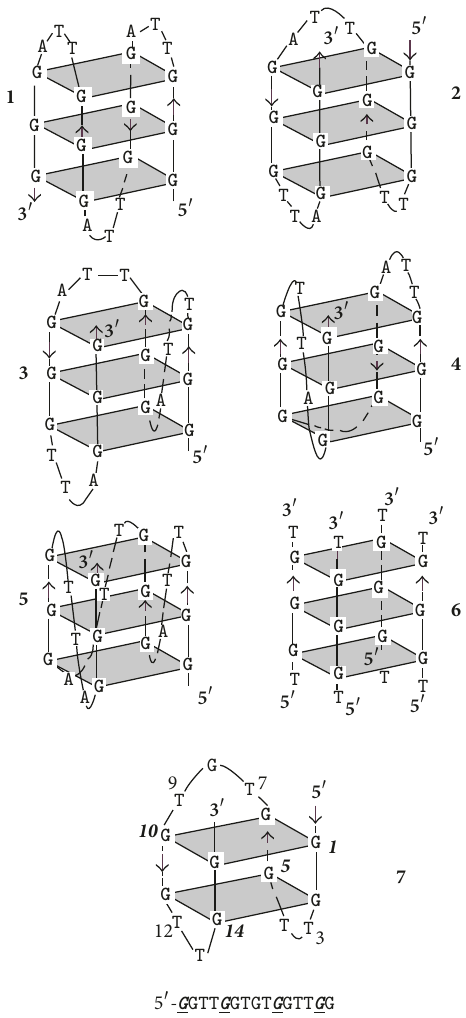
Figure 2: Folding arrangements of the most often cited GQ structures. The intramolecular GQ architectures adopted by the 21-mer htel-21 G 3 (TTAG 3 ) 3 oligodeoxynucleotide under various solution conditions, topologies 1 – 5 . The basket-type antiparallel with 5 󸀠 -to-3 󸀠 edgewise- diagonal-edgewise loops, forming in Na + (topology 1 ); the chair-type antiparallel with three edgewise loops (topology 2 ); the (3 + 1 strands) hybrid-1 with propeller-like, edgewise, and edgewise loops (topology 3 ); the hybrid-2 with two edgewise loops followed by a propeller-type loop (topology 4 ), both hybrids forming in K + solution; the parallel topology with all three loops in propeller-like configuration, as found in crystals containing K + ions (topology 5 ); tetramolecular GQ assembling from four TGGGT DNA chains, [TG 3 T] 4 (topology 6 ). Bottom panel: the two-tetrad, chair-type intramolecular antiparallel topology, folding from the 15-mer TBA oligodeoxynucleotide sequence shown below the topology. The syn dG nucleotides are indicated with underlined letters in italics. For references, see, for example, [8]. Shaded squares represent the G-tetrads displayed in Figure